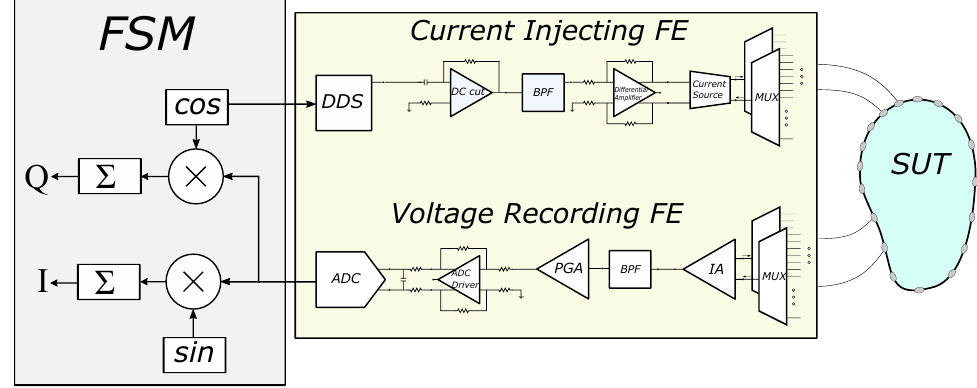
Figure 1. Basic EIT hardware concept. The SUT, current injecting front-end (FE), voltage recording FE, and the finite state machine (FSM) are